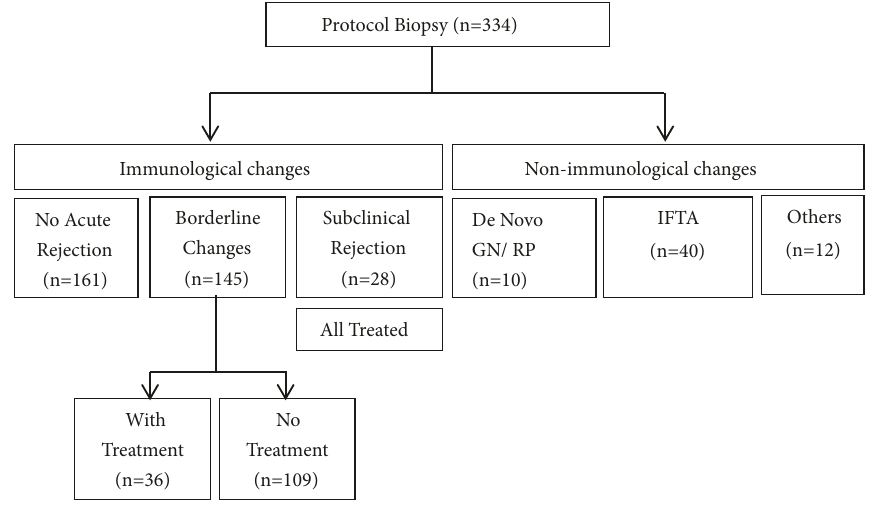
Figure 1: Overview of renal protocol biopsies. Table 1: Clinical characteristic of transplant recipients, stratified by type of histological